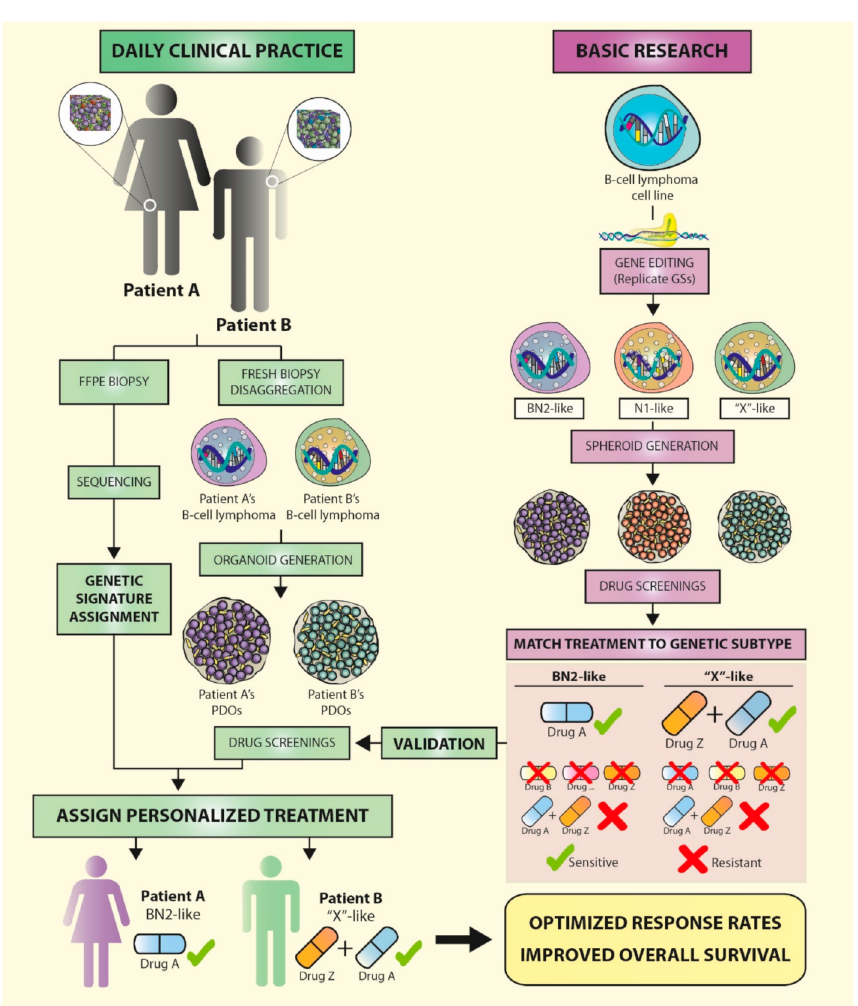
Figure 3. The near future for B-cell lymphoma patients: genetic signatures lead to personalized treatments. Recent studies have identified genetic signatures in diffuse large B-cell lymphoma (DLBCL) patients that can be used to predict outcome and therapy response. In the near future, a combination of newly adapted routines in daily clinical practice (left) and basic research (right) are very likely to lead to personalized treatments for B-cell lymphoma patients, based on the genetic profile of their biopsies. To this end, gene edition of DLBCL cell lines in the laboratory will enable the replication of the DLBCL genetic subtypes (GS) identified in patients (BN2, N1, EZB, MCD, and ST2). 3D organoid-based drug screenings will establish the sensitivities of the different genetic variants to single drugs or drug combinations, at the dose and posology levels, while maintaining the lymphoma microenvironment and intercellular interactions. Once a GS has been matched to a certain treatment regimen, drug sensitivity should be validated in organoids derived from fresh patient biopsies (patient derived organoids, PDOs). Inclusion of biopsy sequencing using targeted panels of selected genes as part of the daily clinical routine will eventually allow personalized treatments to be directly assigned based on the GS of patient biopsies, optimized treatment-response rates, and improved overall survival. FFPE: formalin-fixed,